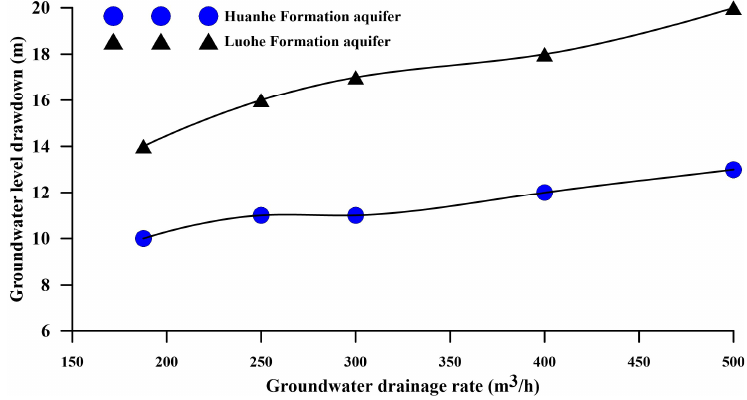
Figure 10. Groundwater level drawdown under the different groundwater